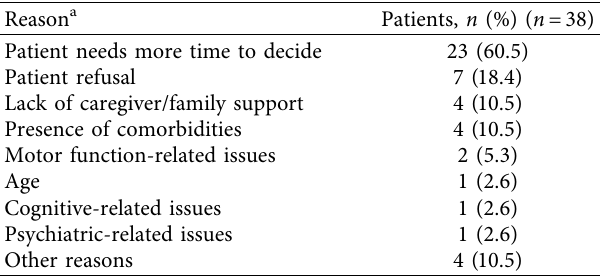
Table 9: Reasons for not planning DAT in eligible patients with